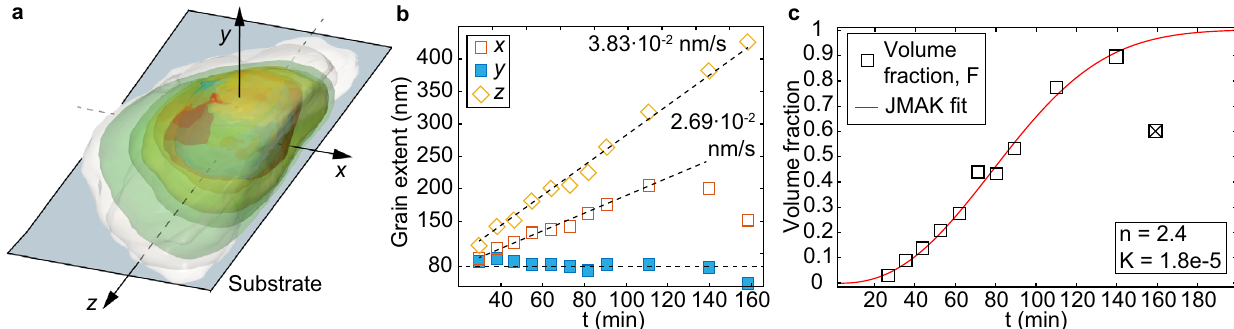
Fig. 2 Morphology and growth kinetics of a single IZrO grain. a Isosurfaces of amplitude ρ ( r ) represent the time steps and corresponding BCDI reconstruction. All reconstructions are aligned with respect to their center of masses. The sample reference frame ( x , y , z ) is aligned with the substrate and principal growth directions of the grain. b Time dependence of the grain dimensions in the sample reference frame. Rates correspond to linear fi ts shown by dashed lines. c The volume fraction F of the IZrO grain as a function of annealing time obtained from BCDI reconstructions (black squares). The solid red line is the nonlinear fi tting curve to the JMAK equation obtained by the trust-region algorithm ( R 2 :